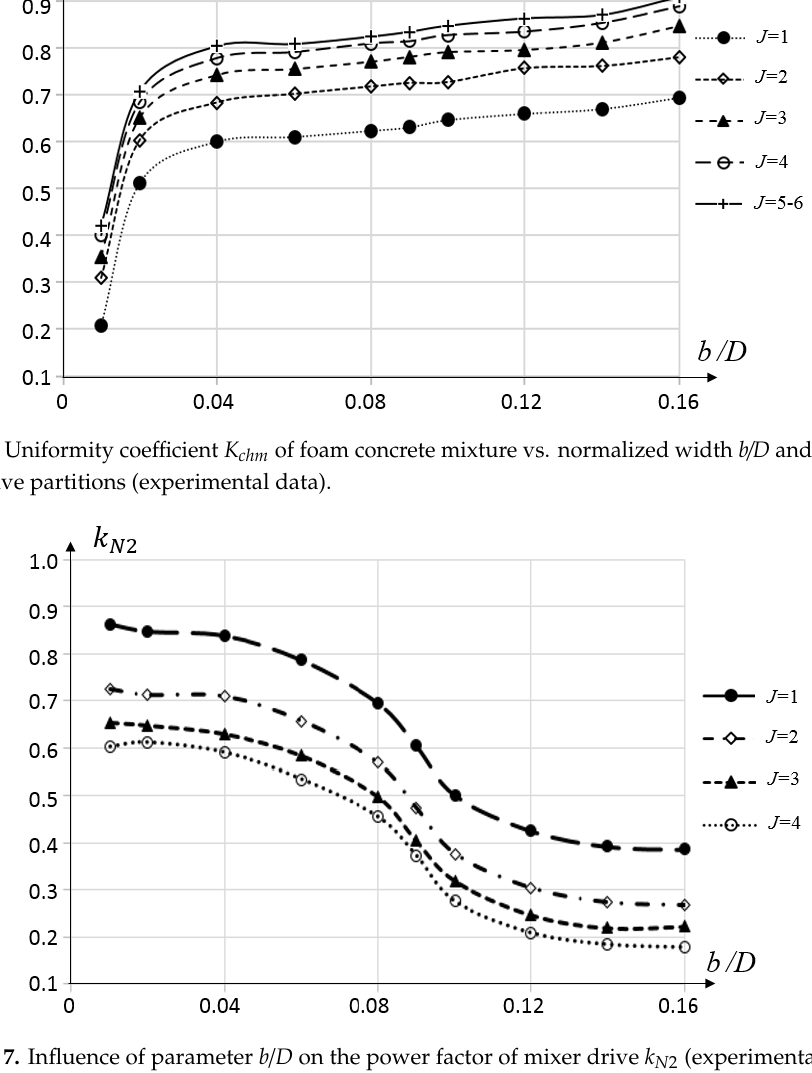
Figure 7. Influence of parameter b / D on the power factor of mixer drive k N 2 (experimental data).